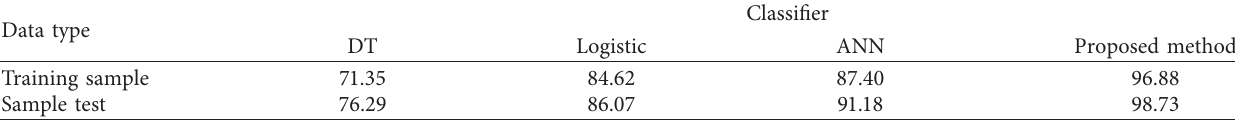
Table 4: Classification accuracy of four classifiers units: